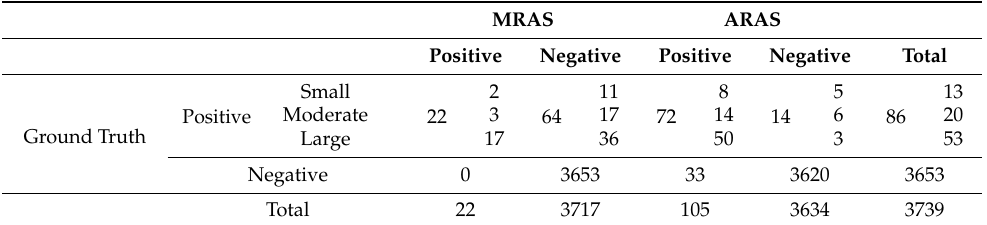
Table 1. Confusion matrices of the Manual Radiology Alert System and Automated Radiology Alert System for pneumothorax.